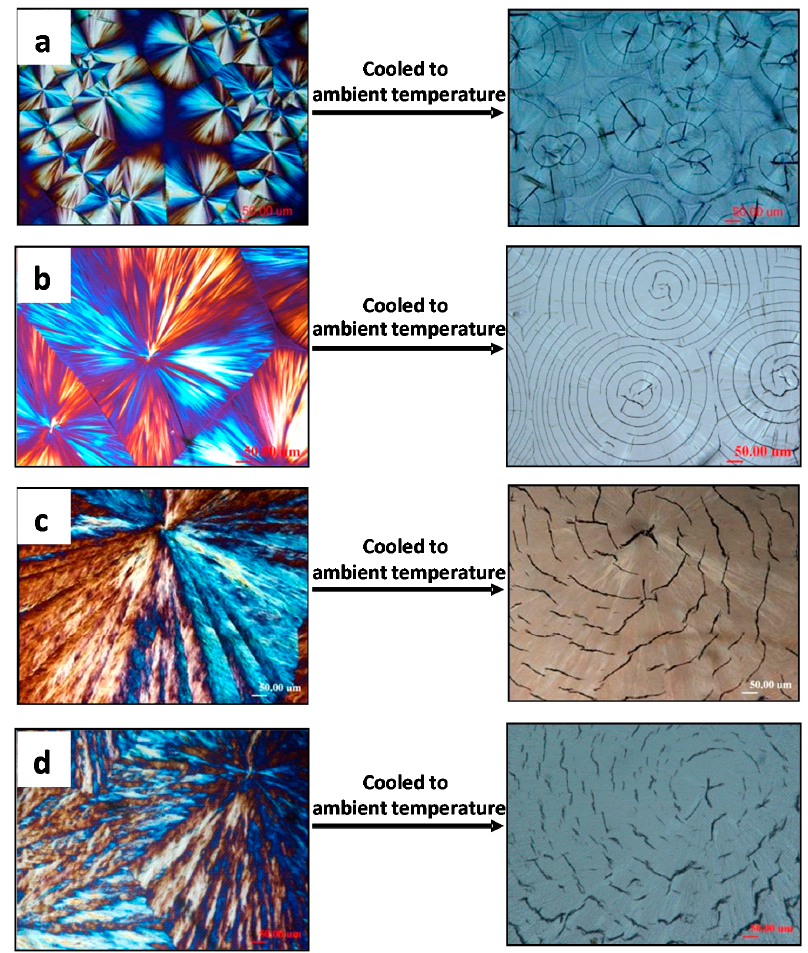
Figure 1. Cracks upon cooling from T c as revealed in optical microscopy morphology of PLLA spherulites crystallized with no top cover (unconstrained) at T c : ( a ) 120 °C; ( b ) 125 °C; ( c ) 130 °C; and ( d ) 135 °C. Reproduced from Ref. [29] with permission from Springer (scale bar = 50 μ m in all graphs). Top-covered PLLA films display entirely different patterns of cracks. Figure 2 shows POM and OM morphology of PLLA(11k) films crystallized with a top cover at T c ranging from 120 to 135 °C, where distinct ring-banded spherulites appear at T c = 125 and 130 °C, respectively. For the samples crystallized at 120 °C or 135 °C, the PLLA spherulites are ringless with smooth lamellae of fine and thin textures. Note that for these two ringless PLLA spherulites ( T c = 120 and 135 °C, respectively), the cracks are correspondingly similar to those seen in the ringless PLLA spherulites discussed in Figure 1. However, for samples crystallized at 125 and 130 °C, the PLLA spherulites show distinct ring bands with alternating bright and dark bands of the rings, with the dark bands apparently owing to light extinction. These ring-banded PLLA samples crystallized at T c = 125 and 130 °C, upon being cooled to ambient, develop cracks (short radial cracks + twin circumferential cracks) that are dramatically different from those in the ringless PLLA spherulites crystallized at same T c = 125 and 130 °C shown in Figure 1. Note carefully that there are actually “dual-rings”, whose positions roughly coincide with the optical dark-bright transitions of alternating bands in the ring-banded spherulites. More precisely, the twin circumferential cracks are located and coincide with the boundaries of the bright and dark bands. For PLLA films crystallized at any T c with or without top confinement, the lamellae there in the ring-banded spherulites or ringless ones are intimately correlated to the crack types formed during cooling from T c to ambient.